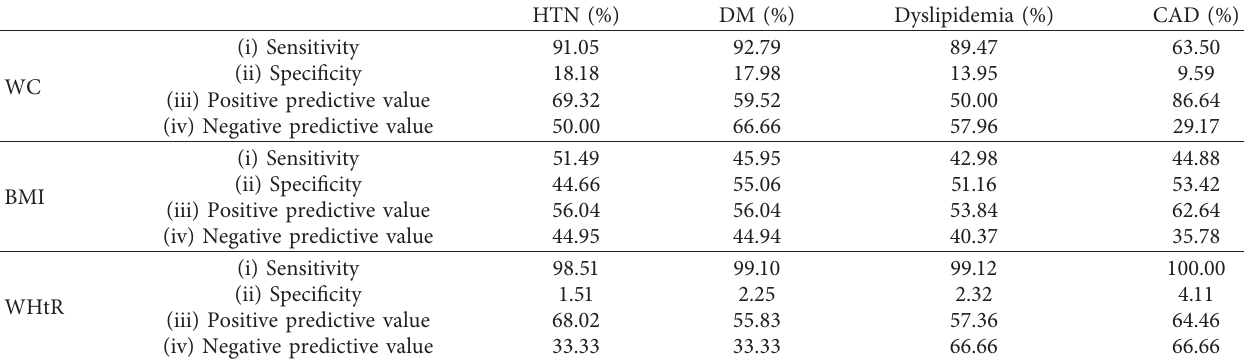
Table 4: Sensitivity, specificity, positive predictive value, and negative predictive value of risk factors and